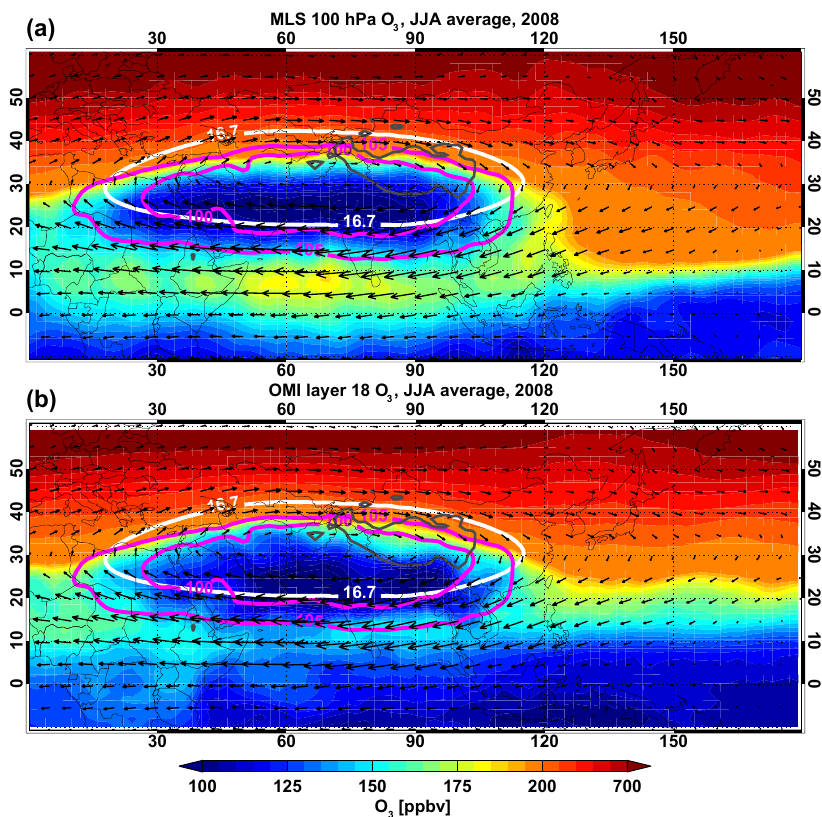
Figure 11. JJA seasonal average O 3 mixing ratio for the (a) MLS 100hPa product and (b) OMI layer 18 product for 2008. Superimposed white contours are the 16.7km GPH at 100hPa and magenta contours are the 100 and 105hPa tropopause pressure, i.e., the intersection of the tropopause with the 100 and 105hPa pressure surfaces. Both MLS and OMI are 2 ◦ × 2 ◦ longitude–latitude binned averages.